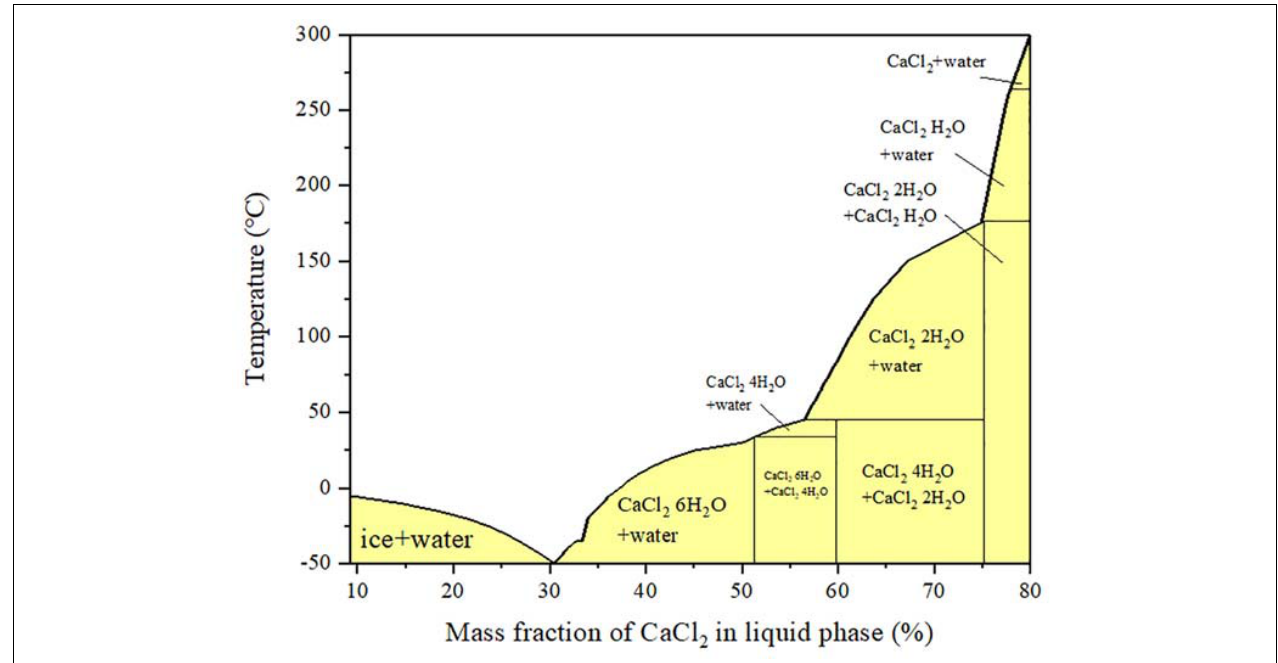
FIGURE 14 | Phase diagram of calcium chloride